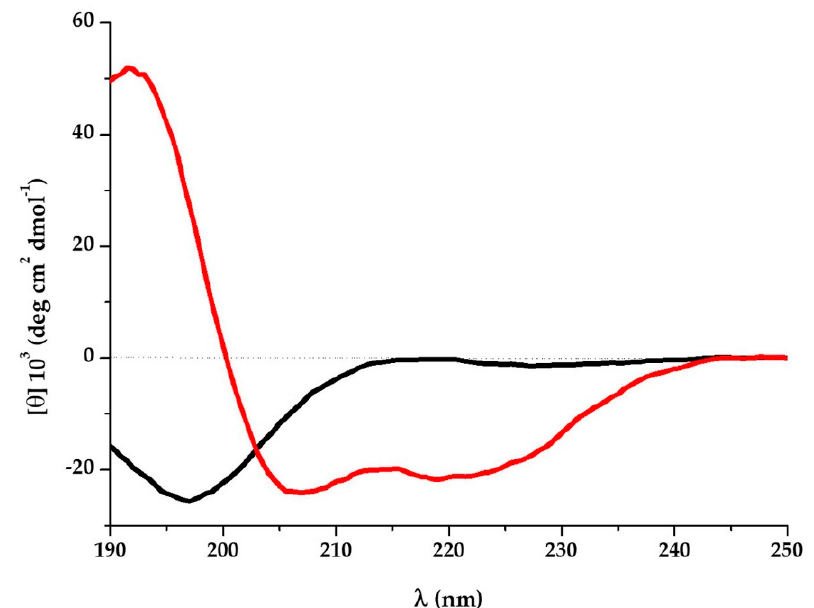
Figure 2. Far-UV circular dichroism (CD) spectra of K13L (100 µM) in aqueous solution (black line) or K13L (50 µM) in 100 mM sodium dodecyl sulfate (SDS) (red line) 5 days after preparation of the starting aqueous solution (1.58 mM).